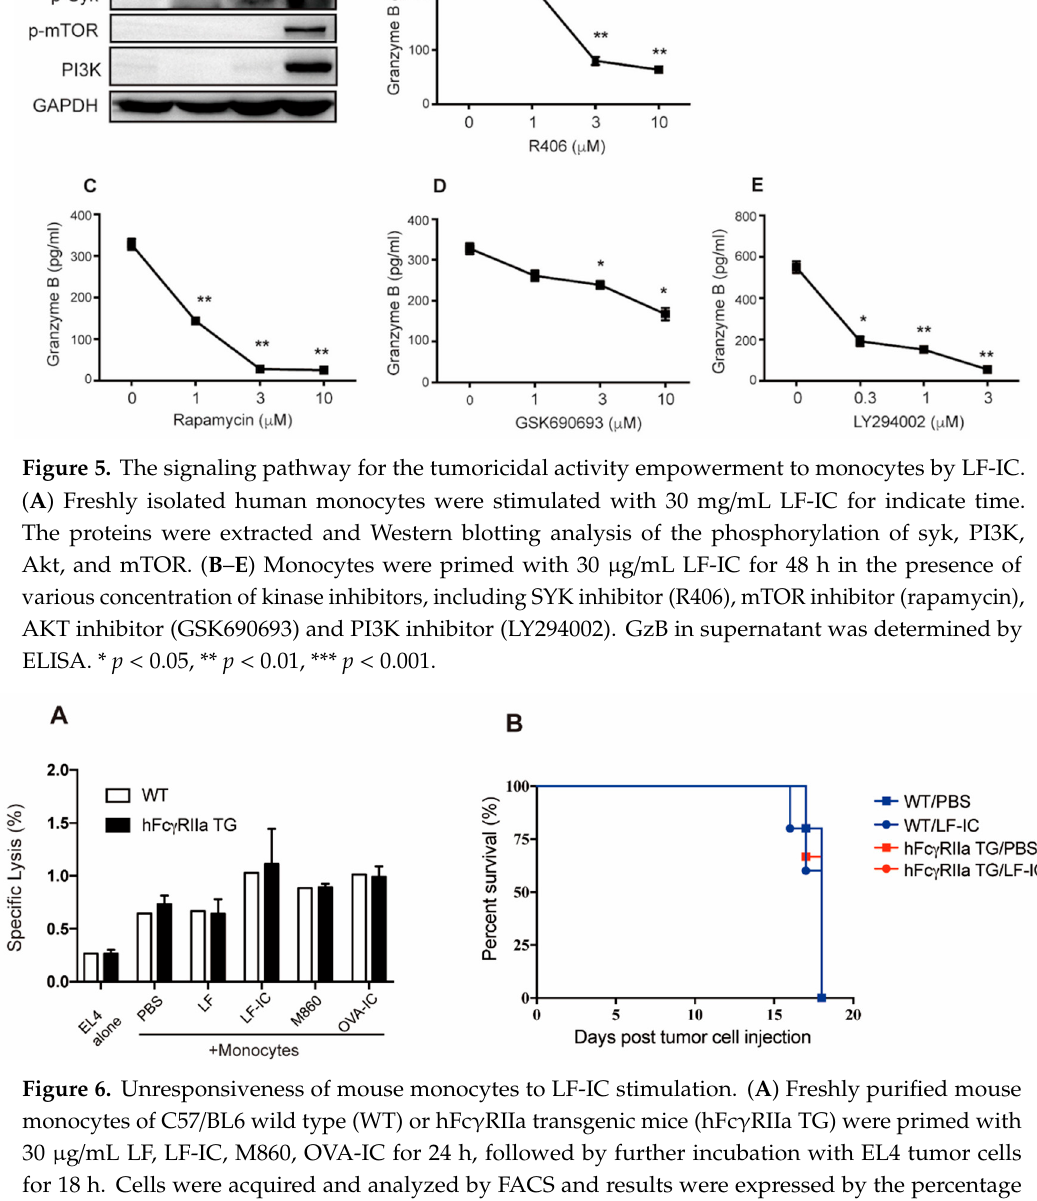
for 18 hrs. Cells were acquired and analyzed by FACS and results were expressed by the percentage of CFSE + PI + cell counts in CFSE + cell counts. * p < 0.05, ** p < 0.01. ( B ) WT or hFcgRIIa TG mice